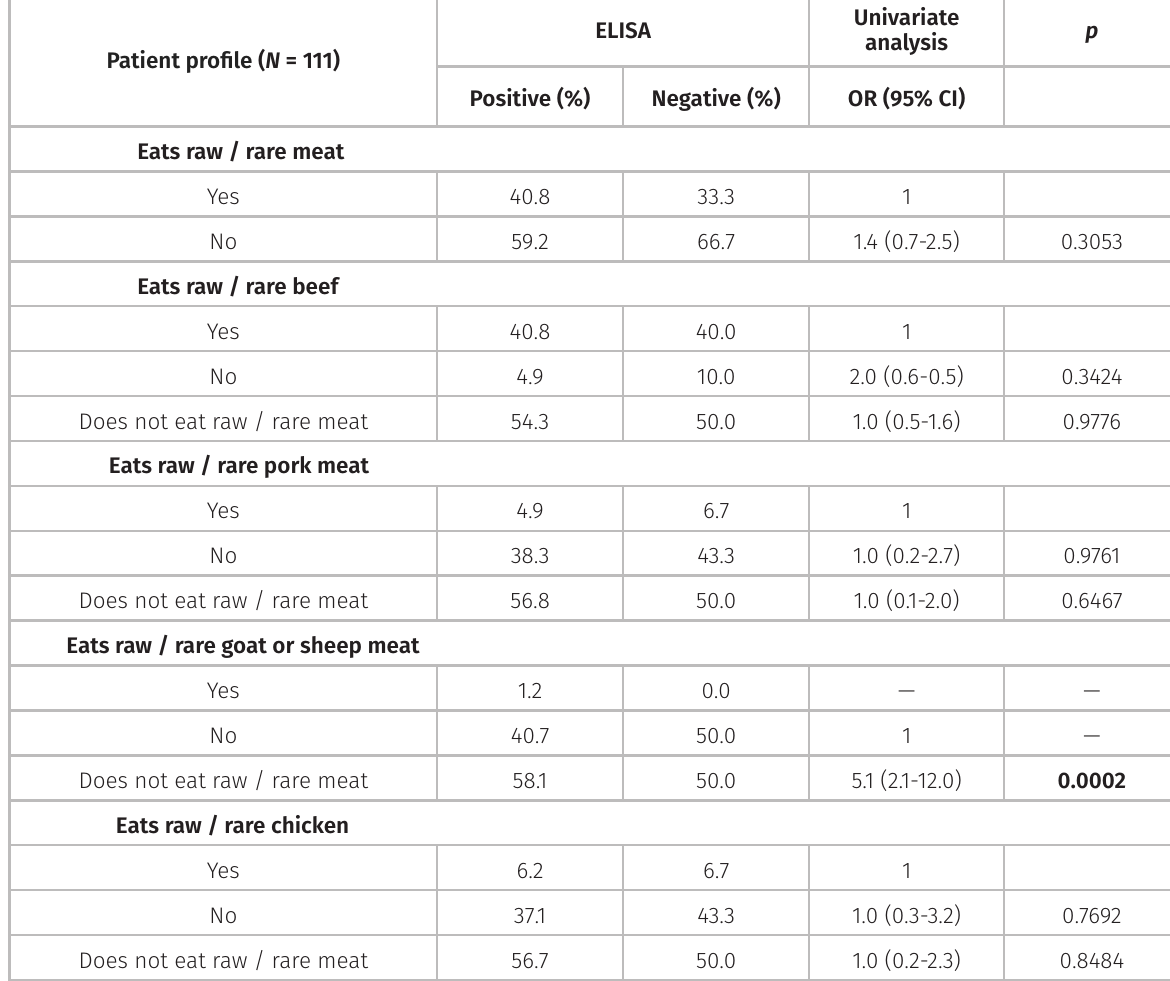
Table IV. Univariate analysis of behaviors associated with T. gondii oocyst ingestion by patients who were attended by the Expert Assistance Service of Foz do Iguaçu city, Paraná state, Brazil, in 2019. Patient profile ( N = 111)